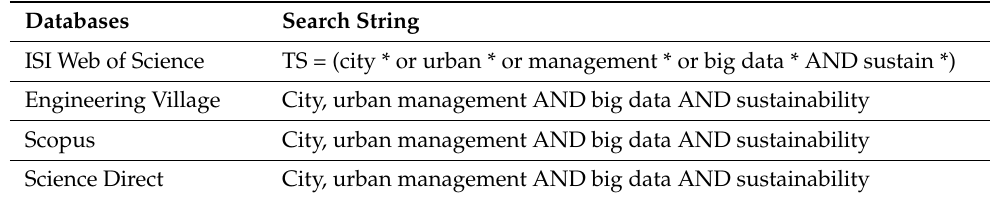
Table 2. Research databases and keyword search